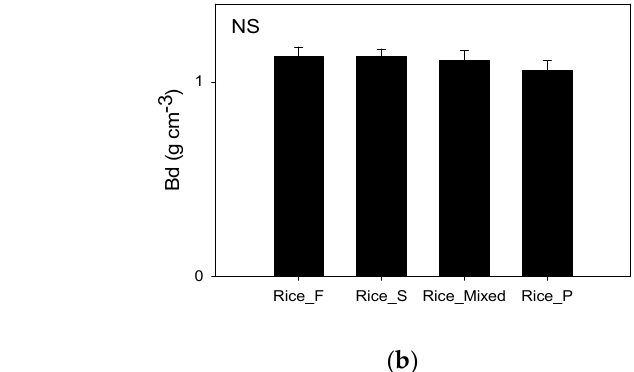
Figure 5. Physical properties of the RRCSs: Particle distribution in terms of clay, silt, and sand ( a ); bulk density of soil ( b ). Note: The bars with the standard error of the mean and labeled with different lowercase letters indicate a difference between rice rotation patterns ( p < 0.05). In the rice cultivation system, different crops are used each year. Rice_ F = rice followed by a fallow period, i.e., no plantation; Rice_S = rice followed by shallots; Rice_Mixed = rice followed by tobacco, maize, and vegetables; and Rice_P = rice followed by potato.